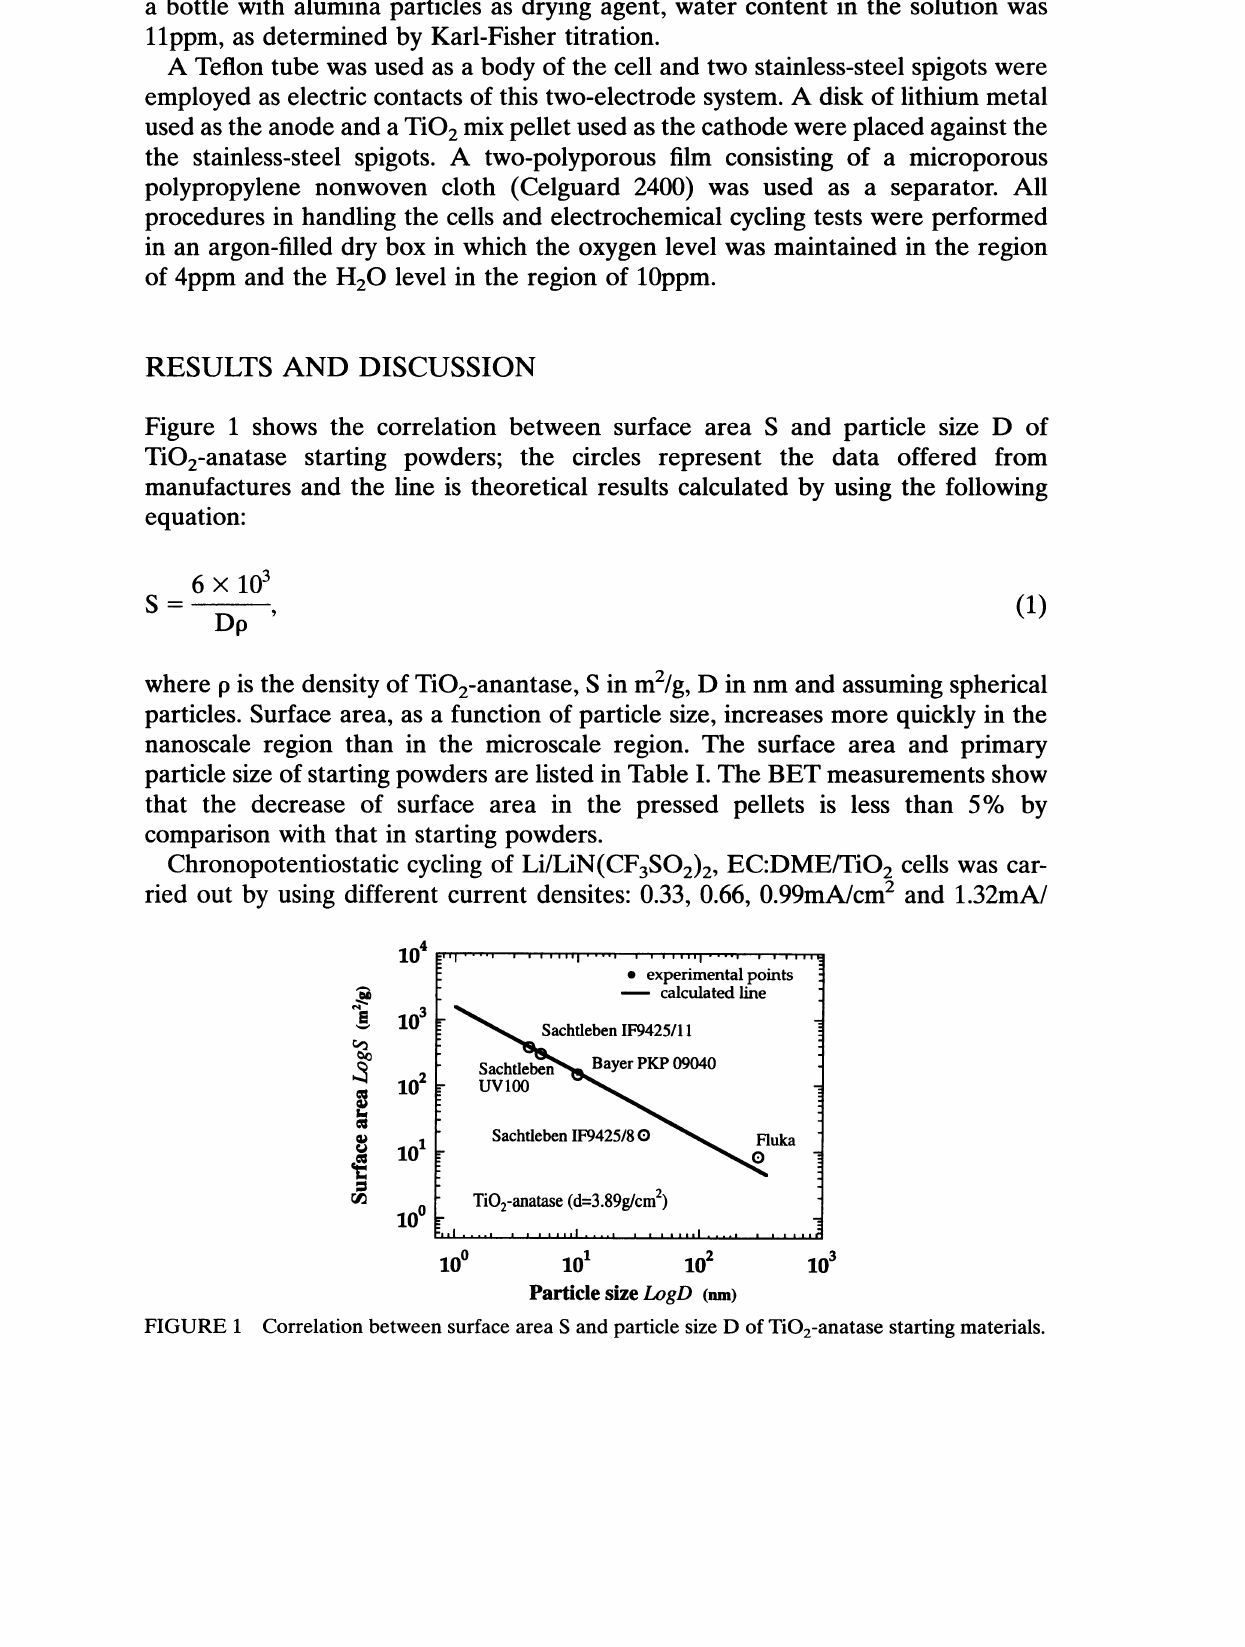
FIGURE 1 Correlation between surface area S and particle size D of TiO2-anatase starting